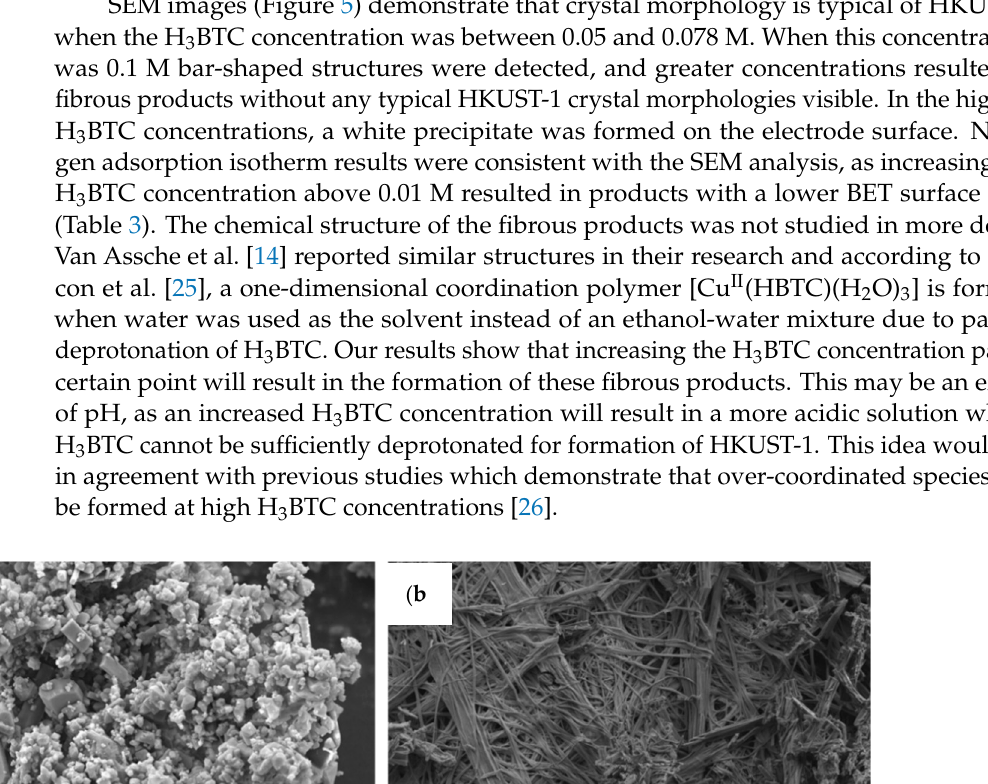
Table 2. The weight of the products on the electrodes and in the solution after 150 min electrosyn- thesis time with varying H 3 BTC concentrations using 0.250 Hz polarity reversal and 0.8 A current. H 3 BTC Concentration (M) Product on the Electrodes (g) Product in the Solution (g)